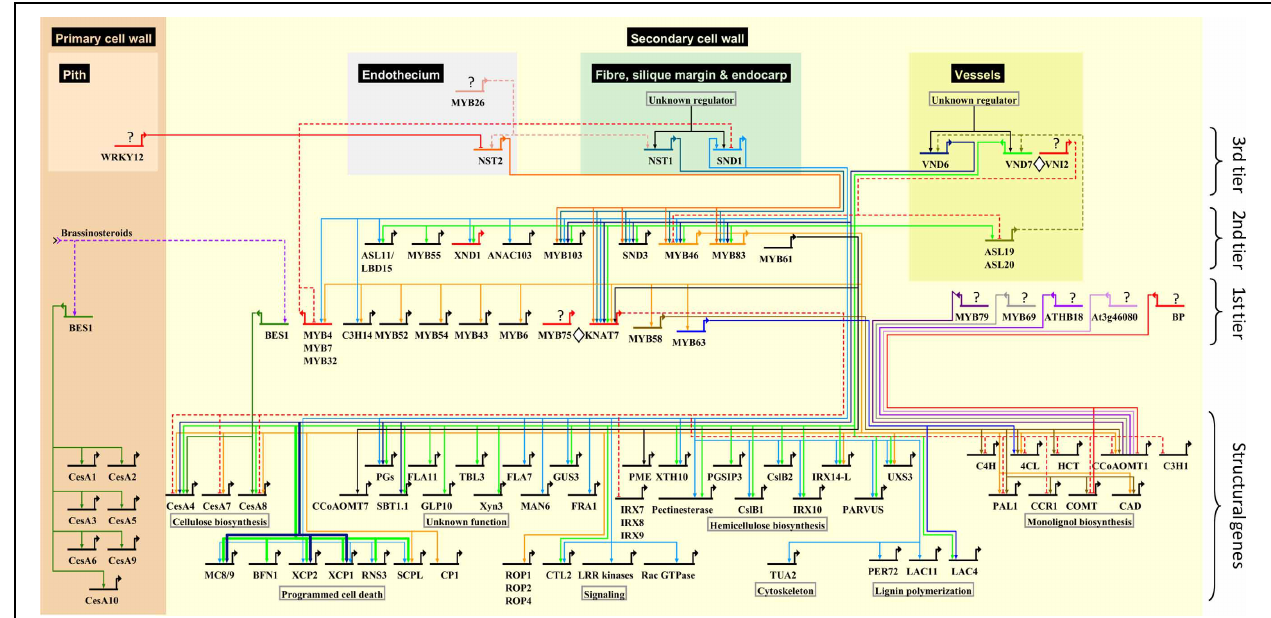
FIGURE 2 | Schematic representation of the protein–DNA interaction network underlying SCW biosynthesis in xylem fibers and vessels and anther endothecium in Arabidopsis . Interactions occurring specifically in primary cell wall tissues are also indicated. Direct protein–DNA interactions involving activation or repression are represented using solid edges, while known regulatory relationships in which the mechanism is unclear are